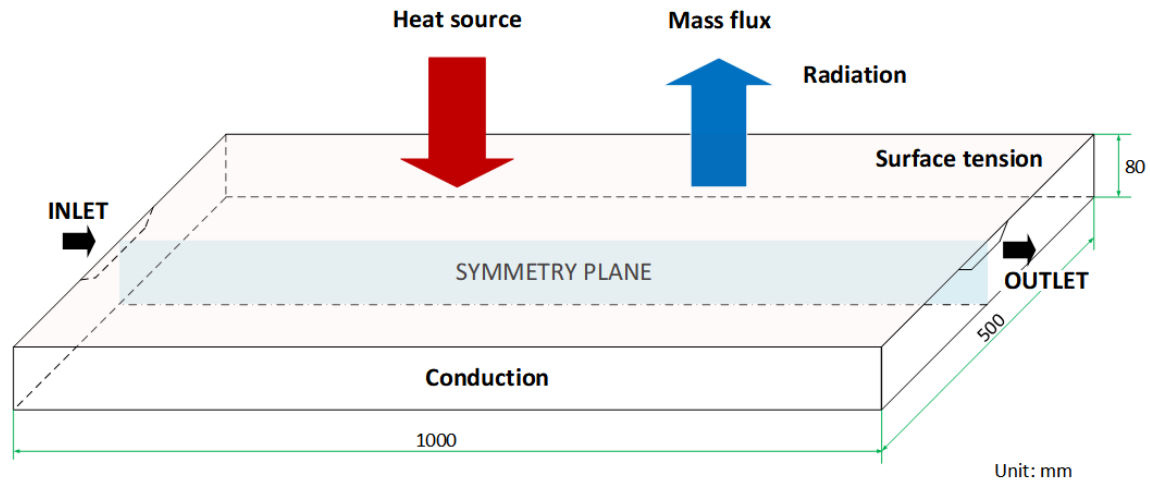
Figure 2. The geometry and boundary conditions of the numerical domain.